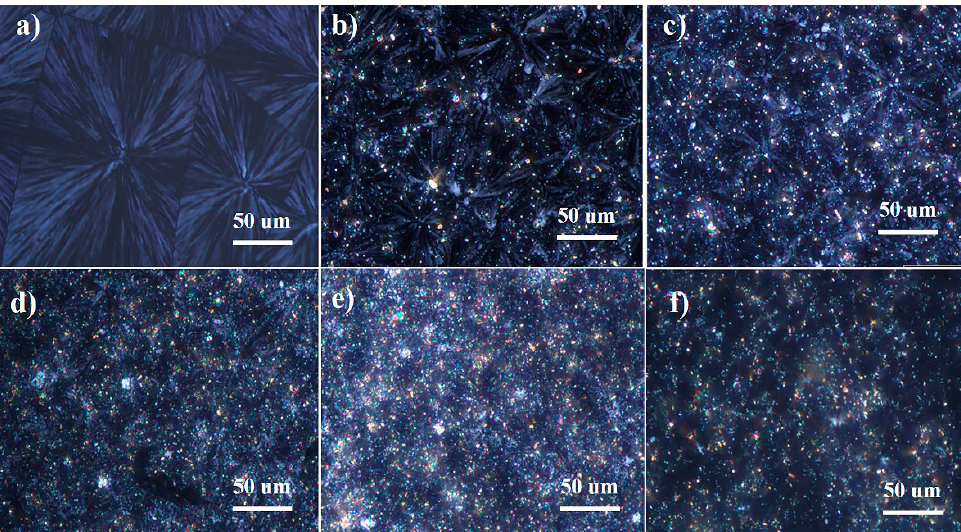
Figure 3. The POM photos of mPP fiber ( a ), mPP-IFR-10 fiber ( b ), mPP-IFR-15 fiber ( c ), mPP-IFR-20 fiber ( d ), mPP-IFR-25 fiber ( e ) and mPP-IFR-30 fiber ( f ).